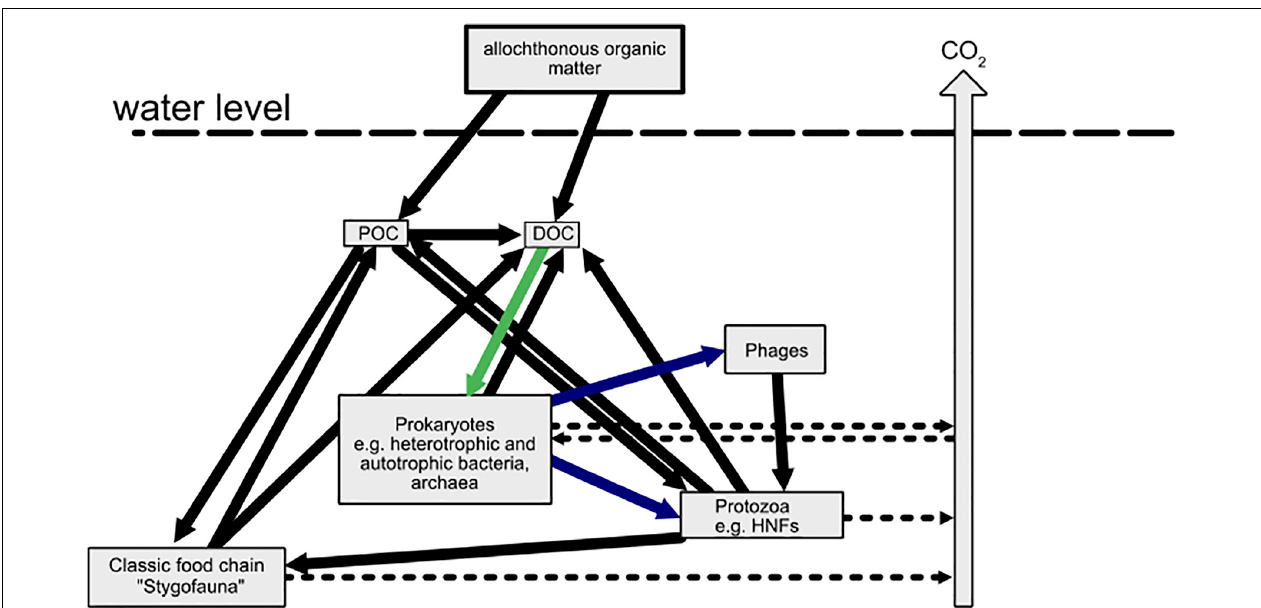
FIGURE 1 | The microbial loop in groundwater ecosystems. In the absence of light, the prokaryotic biomass is largely depended on the import of dissolved organic carbon. Bottom-up control (green arrow) of prokaryotic biomass and top-down regulation (blue arrows) determine the microbial abundance, activity, and